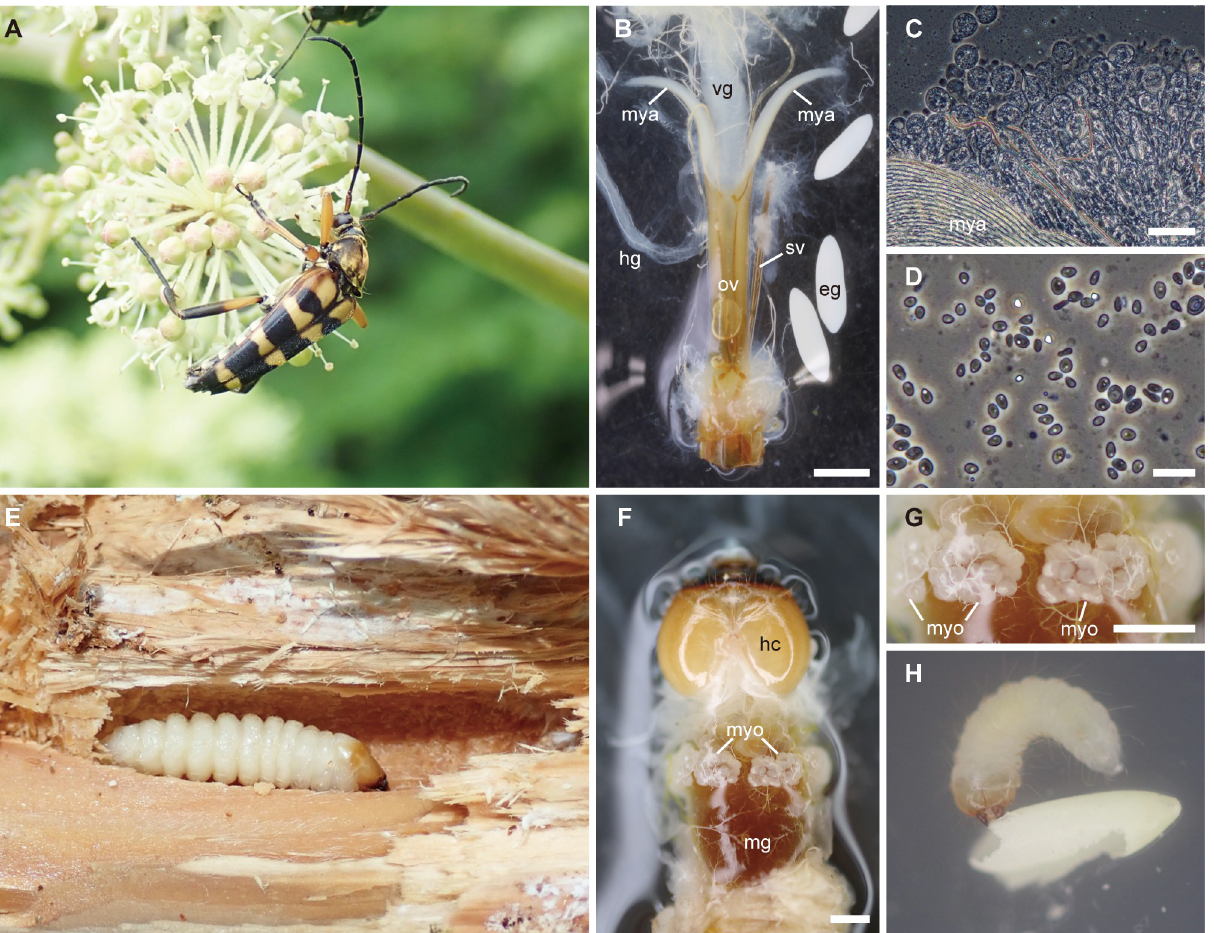
Fig 1. The flower longicorn beetle Leptura ochraceofasciata and associated fungi. (A) A male adult of L . ochraceofasciata visiting flowers of Aralia cordata ; (B) ovipositor, dorsal view; (C) contents of a mycetangium; (D) yeasts in a mycetangium; (E) a larva in decayed wood of Chamaecyparis obtusa ; (F) a larval gut, dorsal view; (G) magnification of mycetomes; (H) a hatched larva feeding on its eggshell. Abbreviations: eg, egg; hc, head capsule; hg, hindgut; mg, midgut; mya, mycetangium; myo, mycetome; ov, ovipositor; sv, spiculum ventrale; vg, vagina. Scale bars = 1 mm (B, F, G), 50 μ m (C), 10 μ m (D).